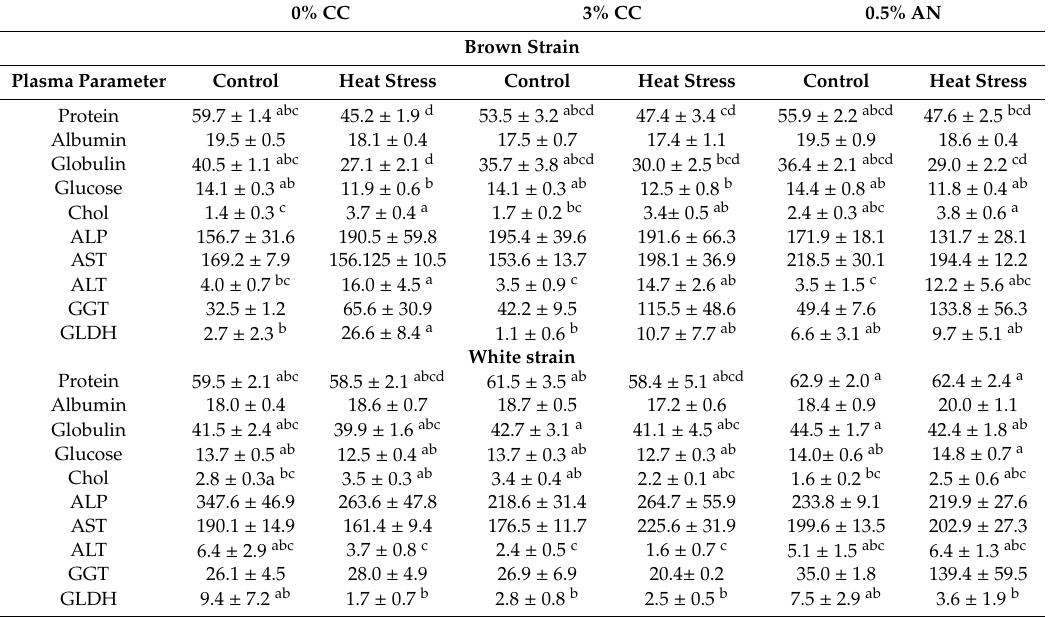
Table 5. Effects of the long-term seaweed intake and a 28-day heat stress on the plasma biochemical analytes in two genetic strains of layers. Values shown as least squares means ± standard error.